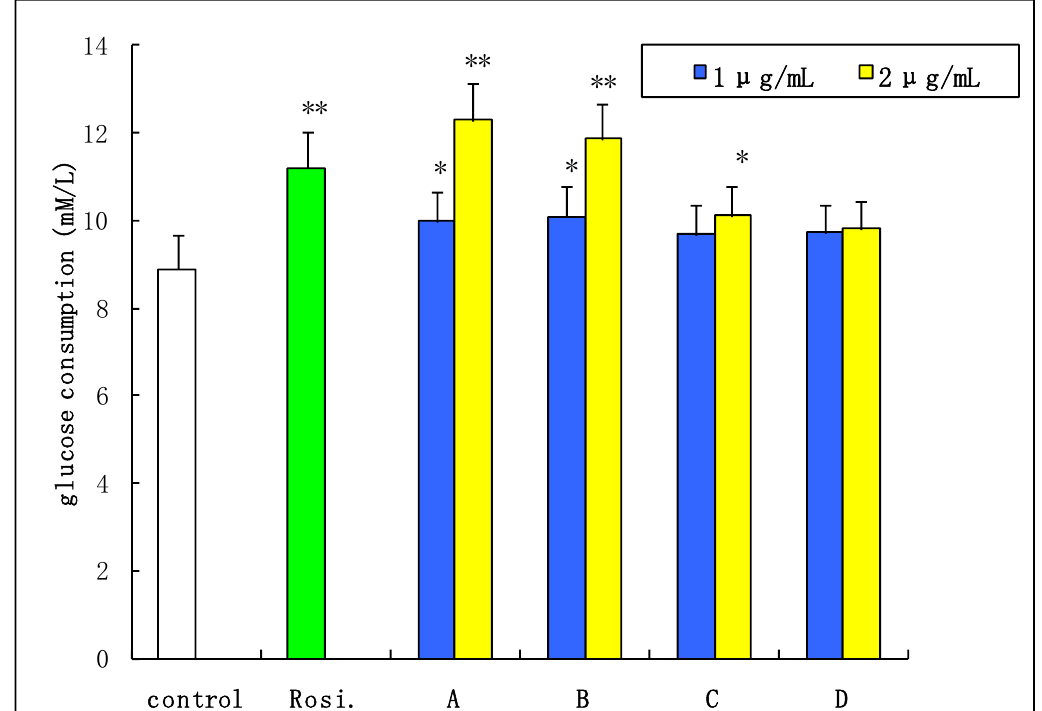
Figure 6. Effects of aporphine alkaloids on glucose consumption in differentiated 3T3-L1 adipocytes. The glucose consumption effect of 1 μ mol/L rosiglitazone (Rosi.) as a positive control (Rosi. vs . control, p < 0.01). Data are the mean ± SD, n = 3. * p < 0.05; ** p < 0.01 vs . control group. A: 2-hydroxy-1-methoxyaporphine; B: pronuciferine; C: nuciferine; D: